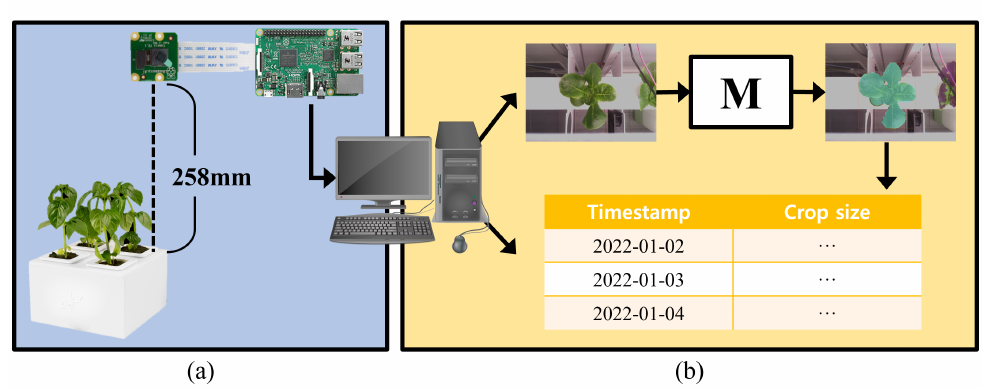
Figure 2. Framework of the proposed monitoring system: ( a ) the data collection procedure; and ( b ) crop size estimation. The image captured at the top of the growth tray is transferred to the server through the secure copy protocol (SCP), and the server can track the growth stage of the crop by calculating and recording the occupied area of the crop in the image.